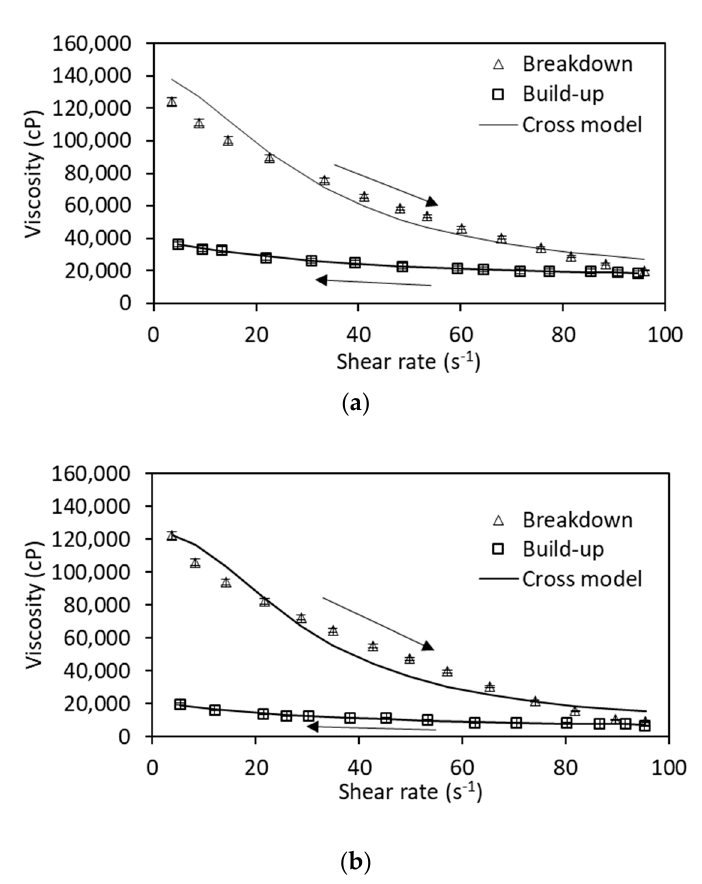
Figure 7. Hysteresis behavior at 30 °C for an extra ‐ heavy oil in the presence of 5 vol % of ( a ) the carrier fluid composed of a xylene/dimethylformamide ratio of 0.2, and ( b ) the nanofluid with S9 nanoparticles at 1000 mg ∙ L − 1 composed by the carrier fluid. The symbols are experimental data, and the continuous lines are from the Cross model.